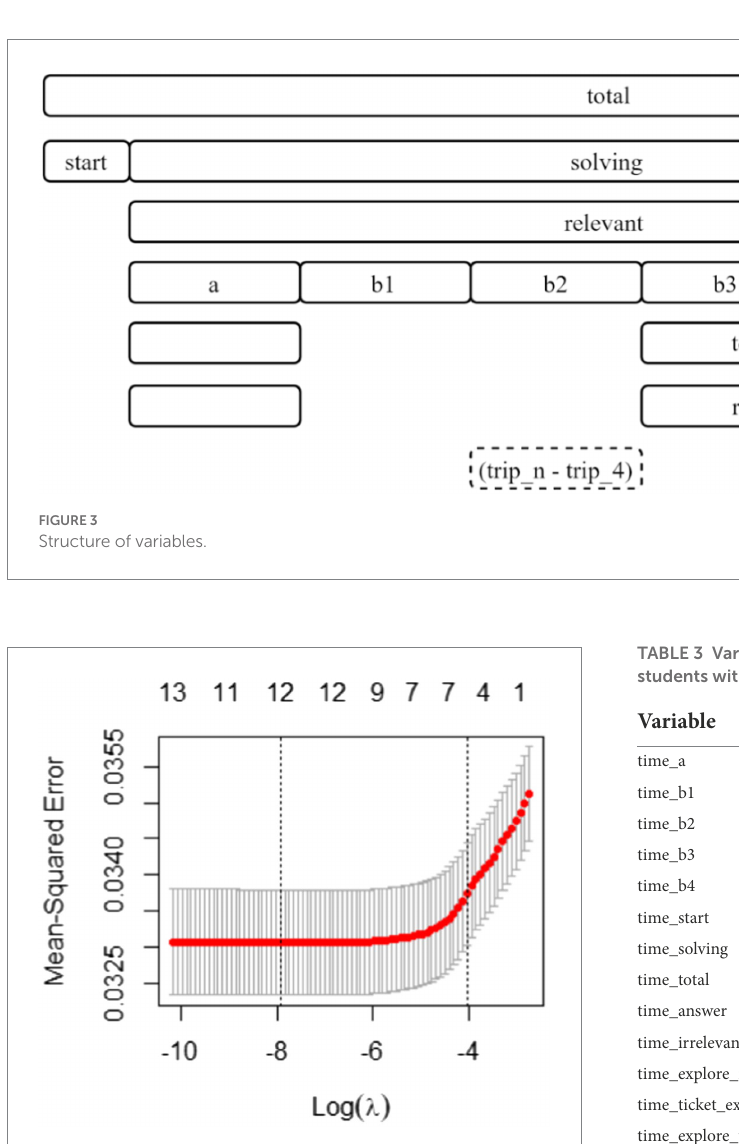
FIGURE 4 10-fold cross-validation result with mean-squared error for students with the correct answer.